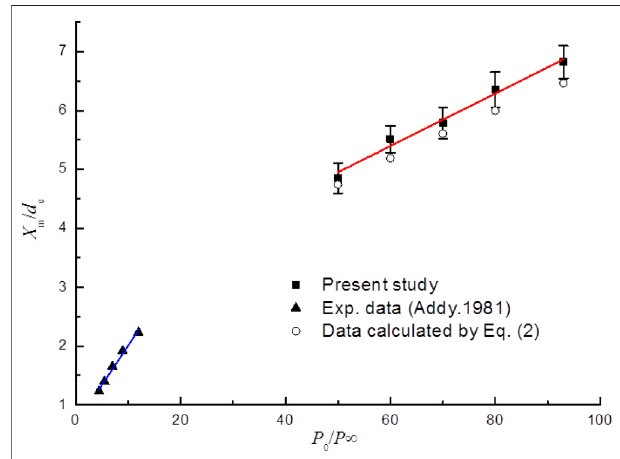
FIGURE 9 | The Mack disc location vs. pressure for circular ori fi ce (d (cid:1) 2 mm).